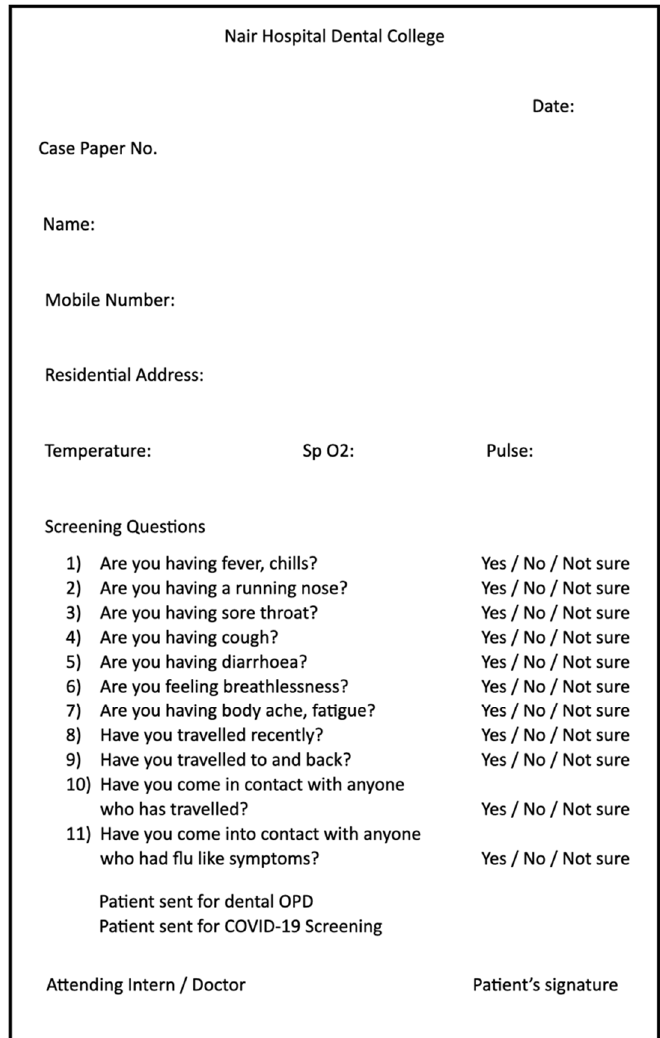
Figure 1. Patient triage form that was recorded for each patient.